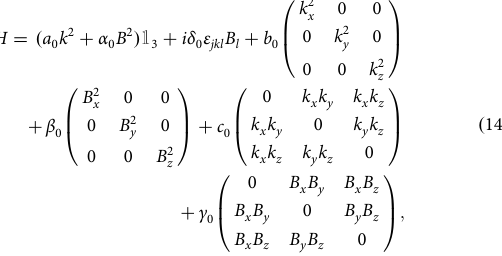
a Product of representations of the G W little group. b Irreps of the little group at the Gamma point. c Irreps of the little group at the point (0, 0,